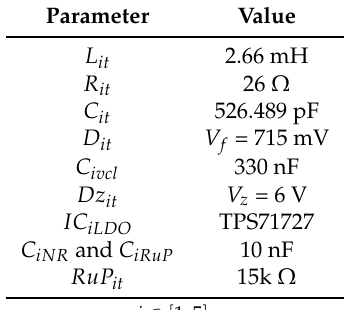
Table 3. Sensor node components values.